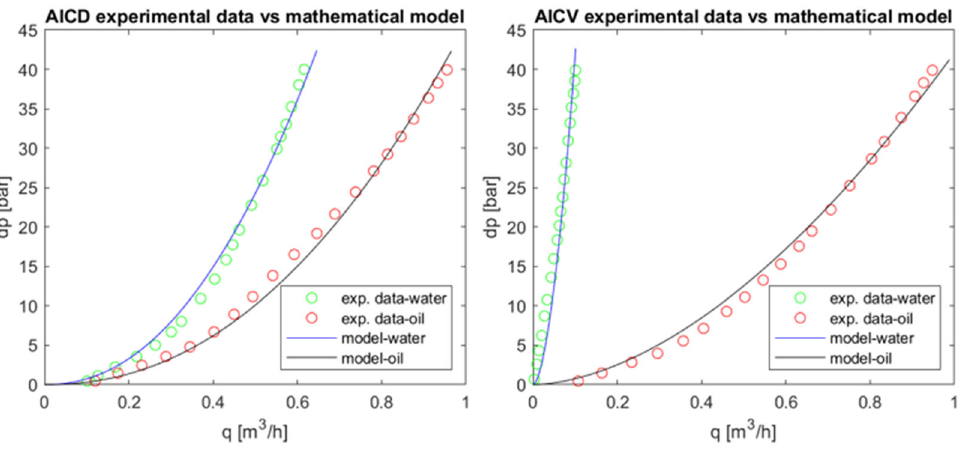
Figure 7. The derived mathematical models of AICDs and AICVs against the laboratory test data. By integrating the developed models for the reservoir and advanced wells with different FCDs, the oil recovery from such wells can be simulated. The obtained results from the simulation for different cases and scenarios covering the uncertainty range were used to generate the required data sets for training and validation of the proxy models. Figure 8 illustrates the simulation results for the cumulative oil and water production from advanced wells with different FCD completions compared to the conventional well (open-hole) for the base case over 10 years.